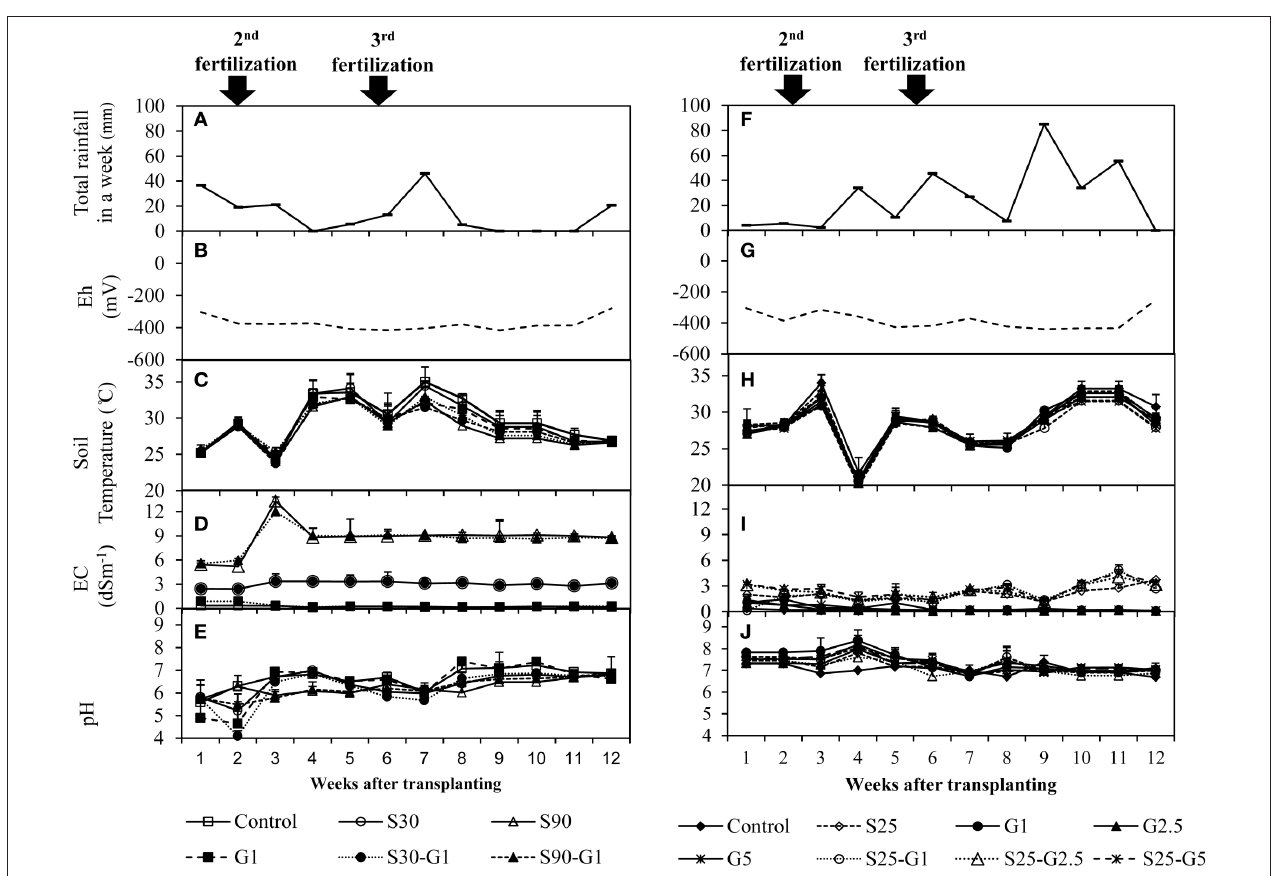
FIGURE 1 | Distribution of rain fall and changes of soil environments under the addition of gypsum and different salinity levels. (A–E) for Experiment (I) and (F–J) for Experiment (II). Error bars indicate standard deviation.